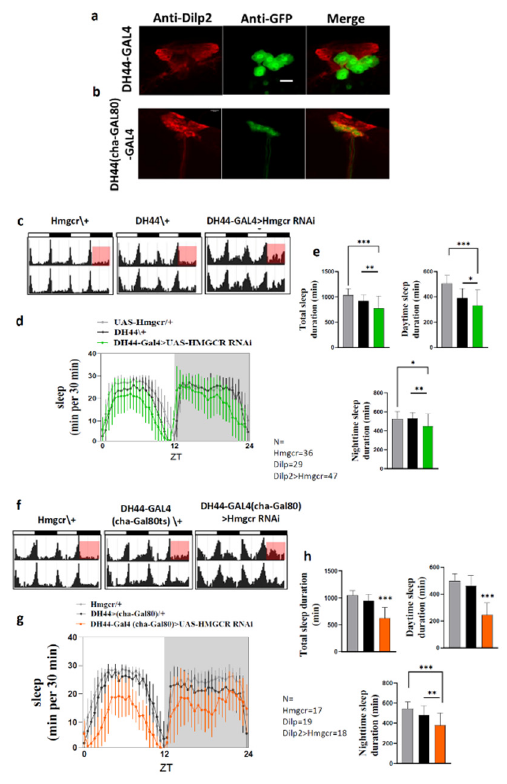
Figure 5. Sleep-activity patterns are affected by Hmgcr knockdown in DH44 neurons. ( a ) DH44-GAL4 Figure 5. Sleep ‐ activity patterns are affected by Hmgcr knockdown in DH44 neurons . ( a ) DH44 ‐ GAL4 driver crossed to UAS ‐ GFP , anti ‐ Dilp2 left, anti ‐ GFP middle and showing complementary to driver crossed to UAS-GFP , anti-Dilp2 left, anti-GFP middle and showing complementary to each each other. ( b ) DH44 ‐ GAL4 ( tubGAL80 ts ) driver crossed to UAS ‐ GFP , anti ‐ Dilp2 left, anti ‐ GFP mid ‐ other. ( b ) DH44-GAL4 ( tubGAL80 ts ) driver crossed to UAS-GFP , anti-Dilp2 left, anti-GFP middle dle and showing complementary to each other. Scale bar = 10 μ m. ( d ) DH44 ‐ GAL4 ( tubGAL80 ts ) and showing complementary to each other. Scale bar = 10 µ m. ( d ) DH44-GAL4 ( tubGAL80 ts ) driver driver crossed to UAS ‐ GFP , anti ‐ Dilp2 left, anti ‐ GFP middle showing complementary to each other. crossed to UAS-GFP , anti-Dilp2 left, anti-GFP middle showing complementary to each other. Scale bar = 10 µ m. ( c – h ) Activity and sleep data for experimental and controls, male flies ( n = 32) in L:D conditions. ( c , f ) White bars indicate daytime (ZT0–12); black bars indicate night (ZT 12–24). The genotypes are indicated above the panels. Red boxes denote the locomotor activity during the